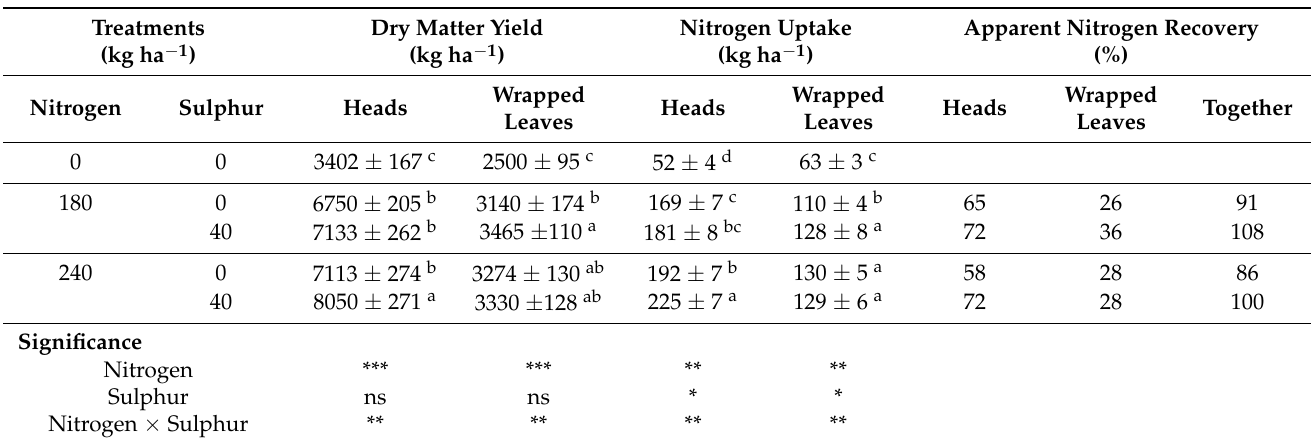
Table 2. Effects of nitrogen and sulphur fertilisation on dry matter yield and nitrogen measures for cabbage heads and wrapped leaves and the nitrogen and sulphur